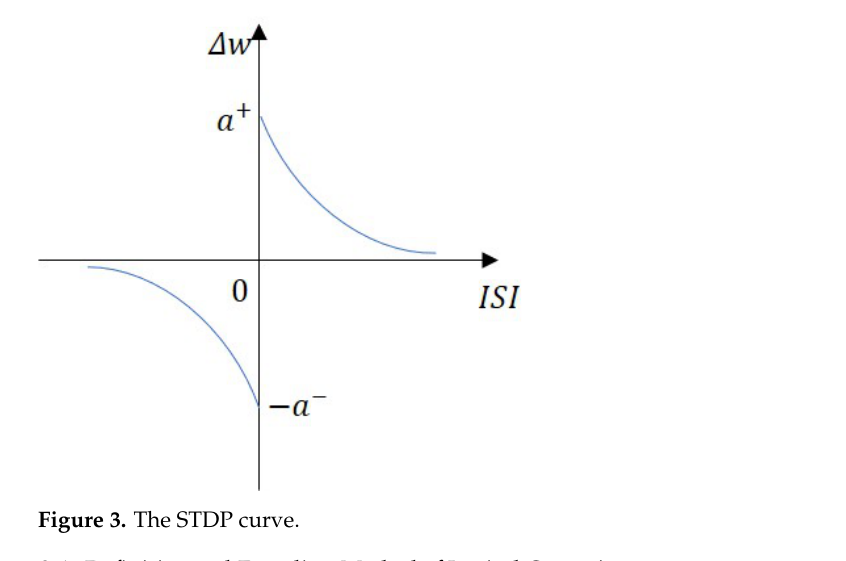
Figure 2. The network structure of SNN logical operation module.